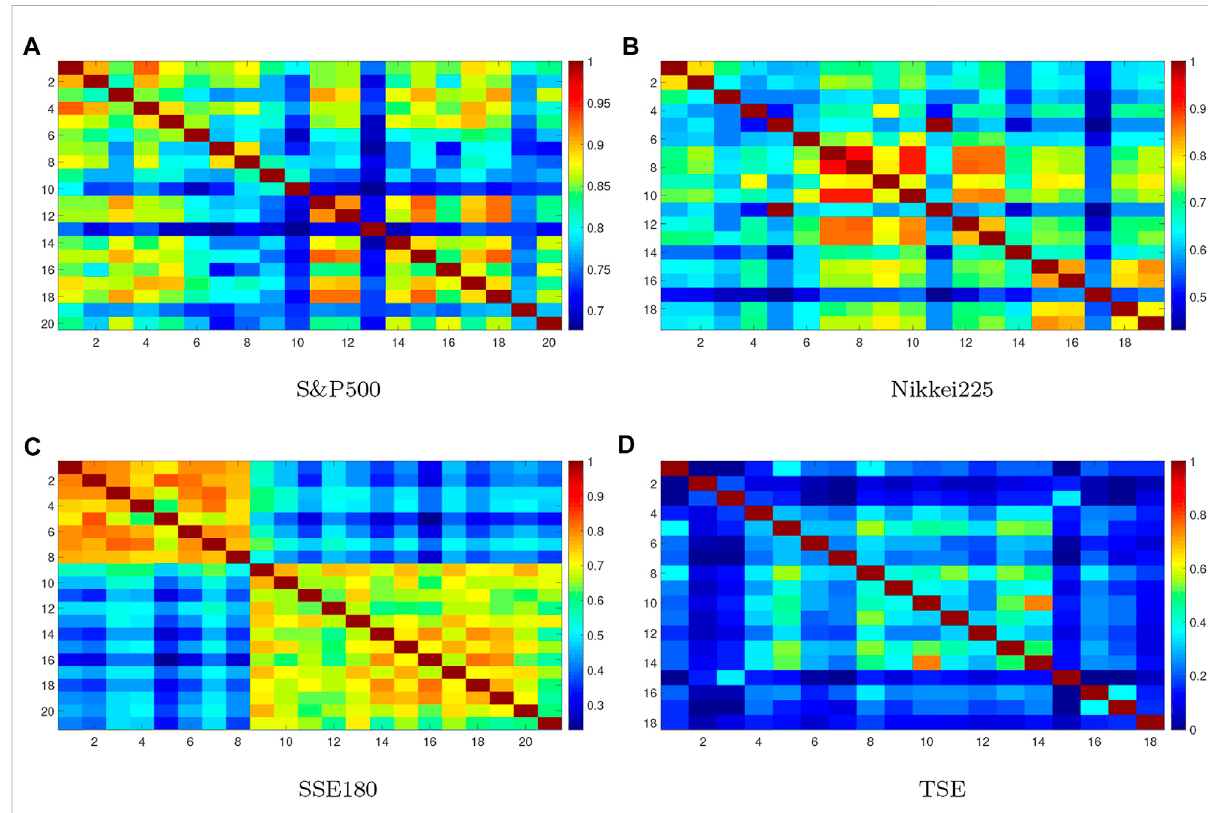
FIGURE 1 Color image of correlation matrices. Warmer colors show higher cross-correlation between components. (A) S&P500, (B) Nikkei225, (C) SSE180, (D)